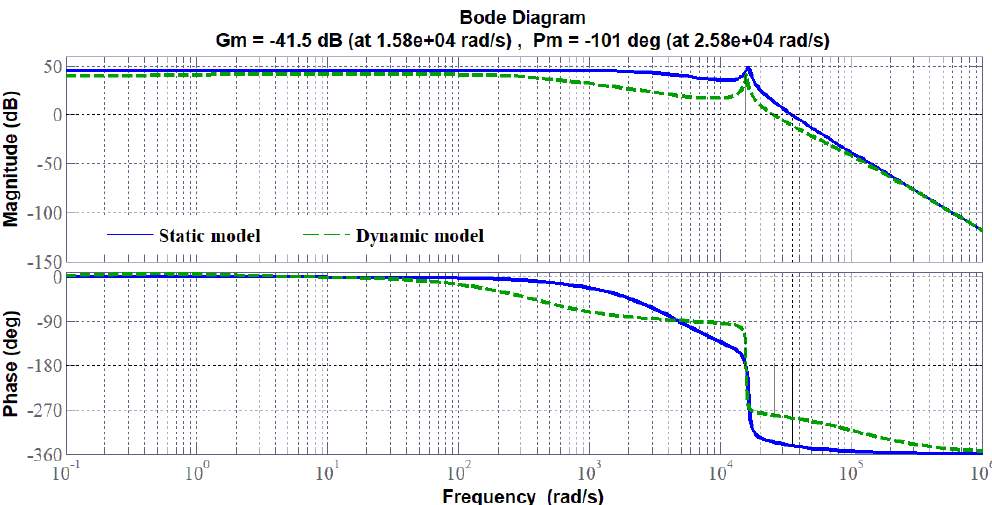
Figure 22. Bode diagram of the transfer function of the stacked interleaved buck converter (SIBC) either with a static or a dynamic model.